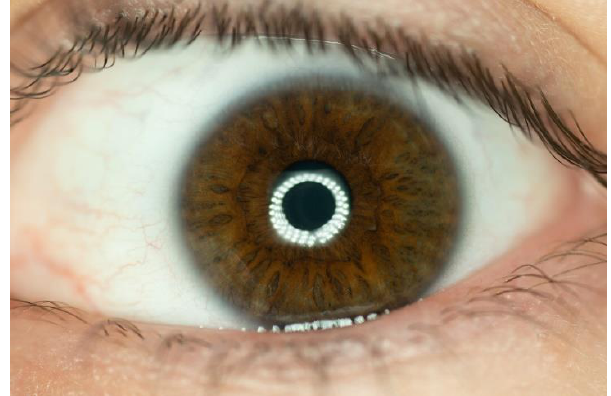
Fig. 4: Detailed image of iris.